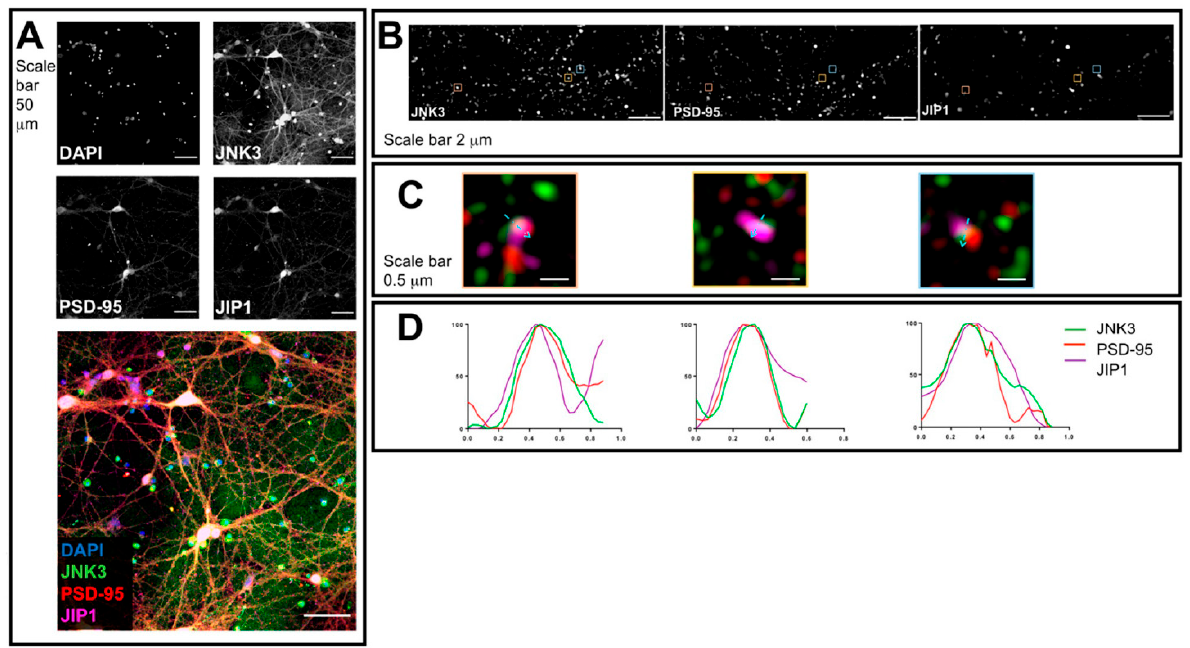
Figure 1. Confocal microscopy and SIM outputs used to assess JNK3–JIP1–PSD95 colocalization. ( A ) Neurons were fixed and stained with anti-JNK3 (green), anti-PSD95 (red), and anti-JIP1 (violet). Images were obtained using a Nikon N-SIM confocal microscope and overlaid to assess protein localization. Nuclei were stained with Hoechst. Scale bar of 50 μ m. ( B ) 3D-SIM images were acquired with a 100× objective. Scale bar of 2 μ m. Squares represent the location of the inset present in panel ( B ). ( C ) Merged images of reconstructed 3D-SIM images of JNK3 (green), PSD95 (red), and JIP1 (violet). Scale bar of 0.5 μ m. ( D ) Intensity profile (green for JNK3, red for PSD95, violet for JIP1) representing the values indicated by the arrows in panel ( C ). The values are normalized to 100 (arbitrary unit).